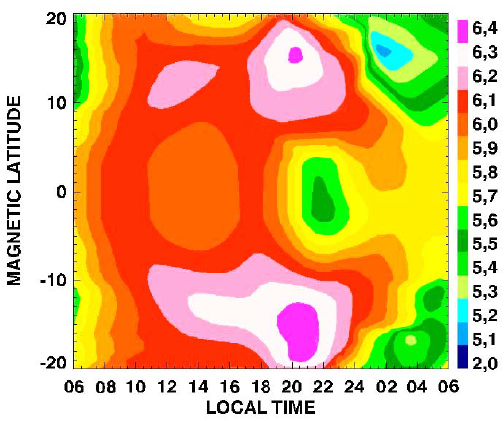
Fig. 4. Ionospheric electron density peak ( n m ) as a function of mag- netic latitude and local time generated by the LION model for av- erage solar conditions in the Brazilian longitudinal region, during summer in the Southern Hemisphere.